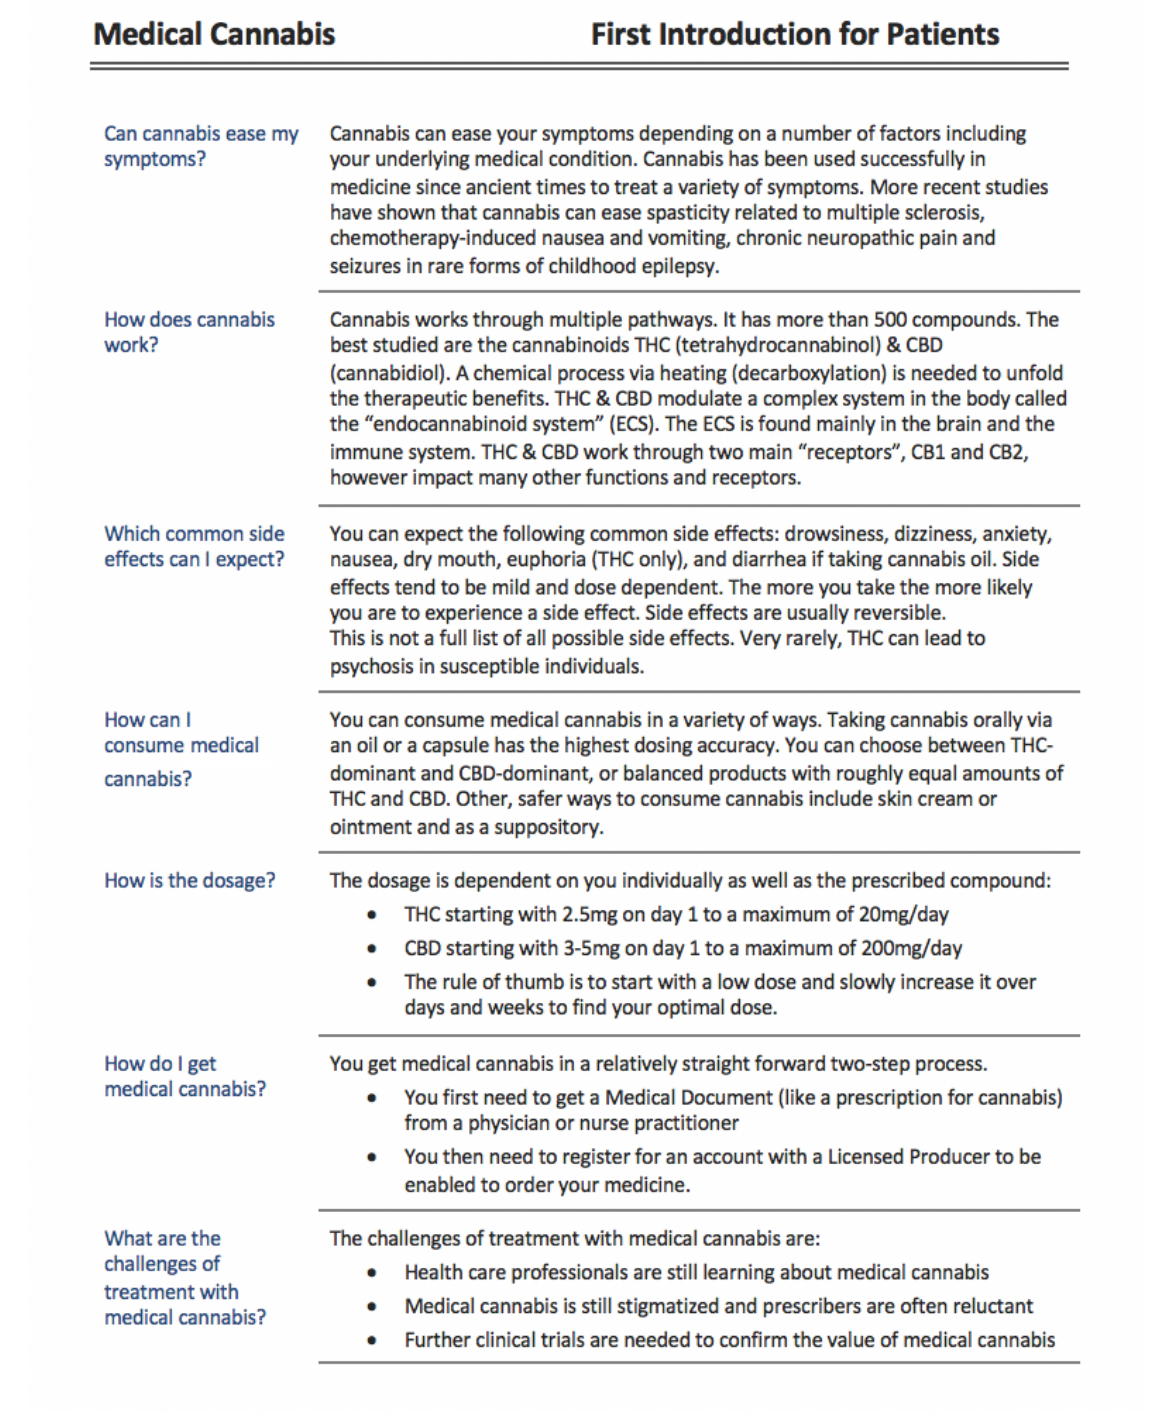
Figure 5. Proposed document-engineering methodology (DEM)-1-pager for patients interested in medical